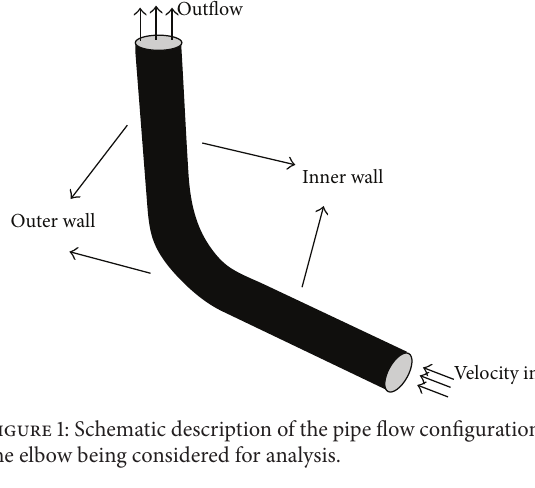
Figure 1: Schematic description of the pipe flow configuration with the elbow being considered for analysis.